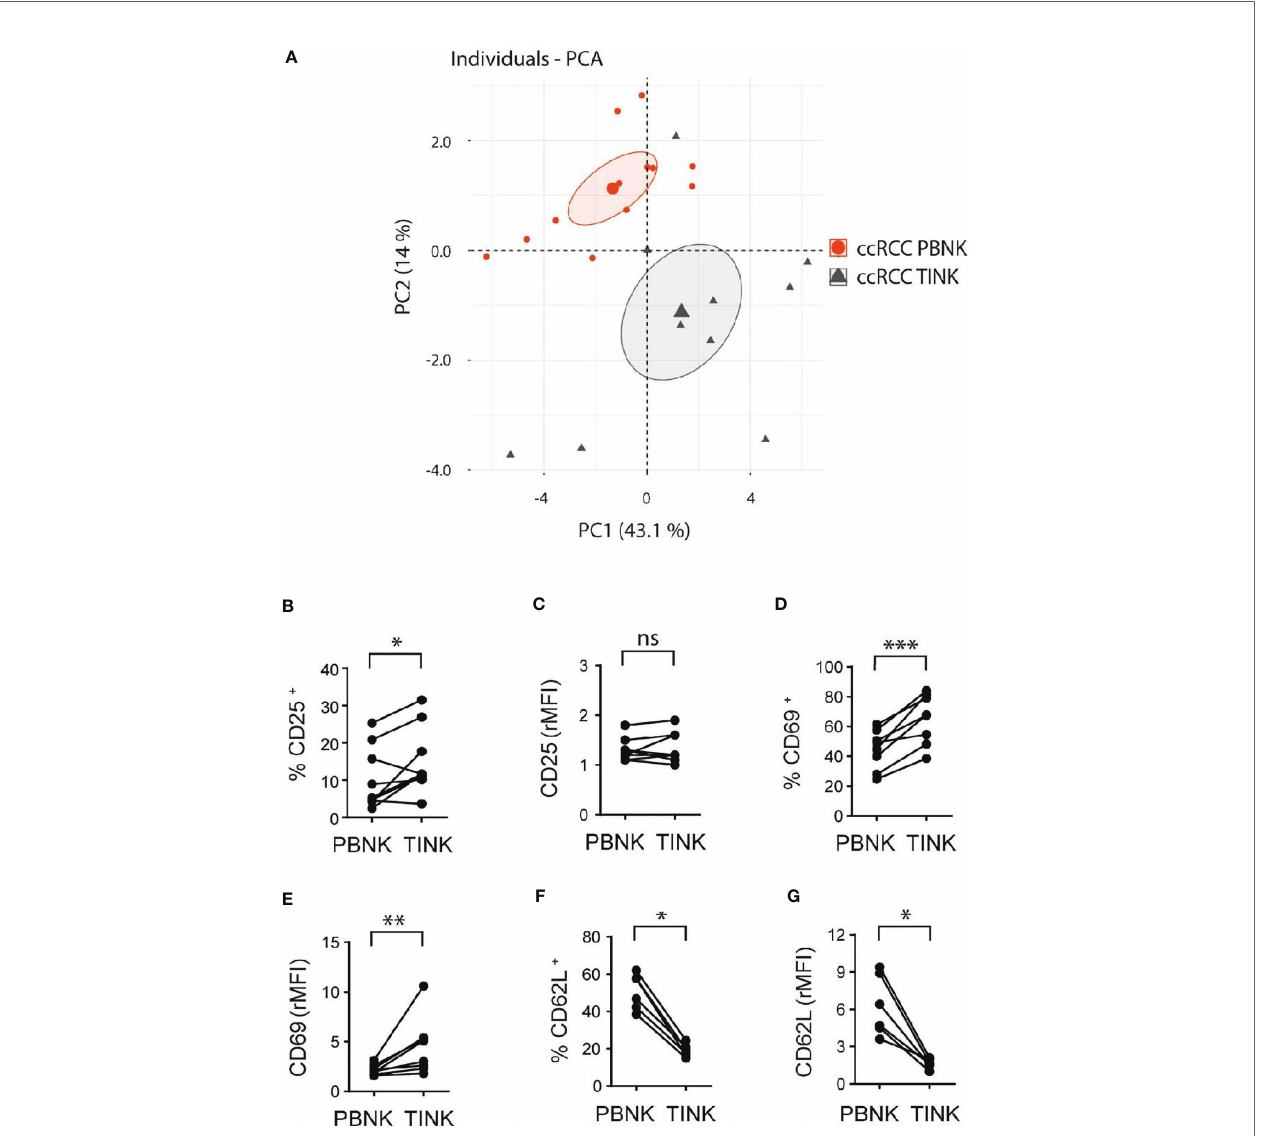
FIGURE 3 | Cell surface markers differentiate TINK from PBNK in ccRCC and indicate that TINK from ccRCC patients exhibit an activated phenotype. rMFI of the molecules analyzed on CD3 - CD56 + cells from PBNK and TINK from ccRCC patients were used to perform PCA (A) . The graph of individuals with the con fi dence ellipse is shown. Also, PBNK and TINK from ccRCC patients were analyzed by FC to compare the frequency of CD25 + cells (B) , the intensity of expression of CD25 (C) , the frequency of CD69 + cells (D) , the intensity of expression of CD69 (E) , the frequency of CD62L + cells (F) , and the intensity of expression of CD62L (G) . In (C, E, G) , relative MFI (rMFI) was used instead of MFI because the FMO was different for PBNK and TINK. n =9 (B, C) ; n =8 (D, E) ; n =6 (F, G) . A two-sided paired t-test was used in (B, D) A two-sided paired t-test with Wilcoxon rank test was used in (C, E – G) . ns, not signi fi cant; * p < 0.05; ** p < 0.01; *** p <